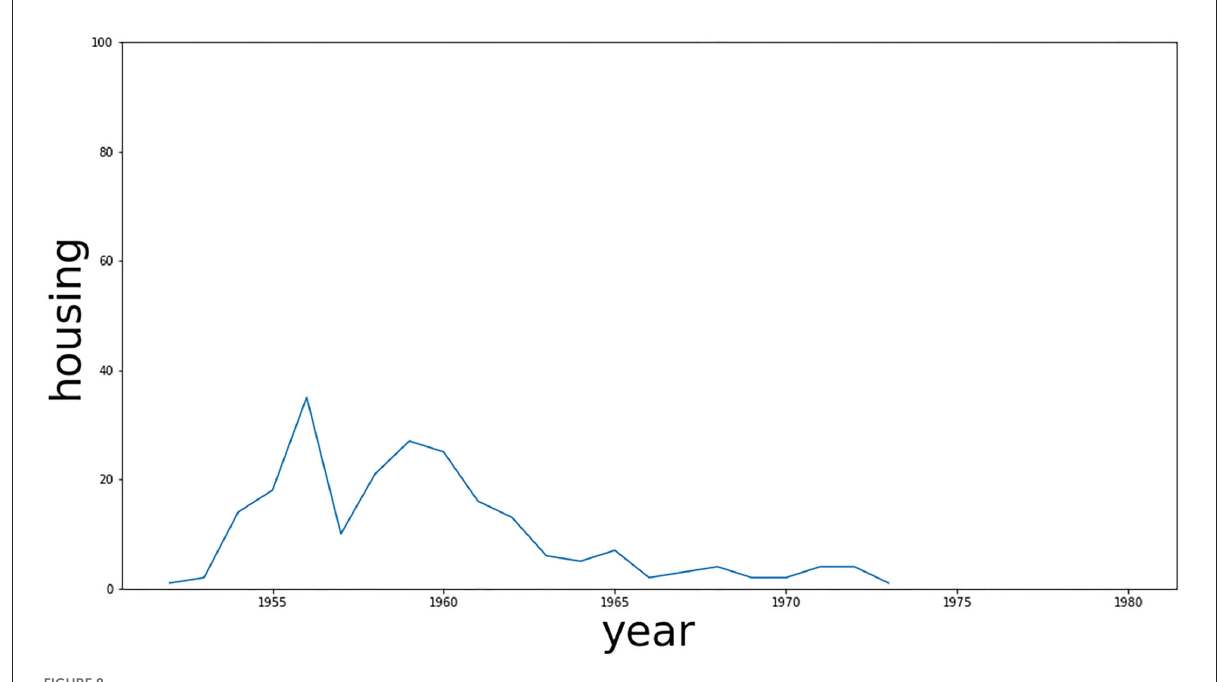
FIGURE8 Housing events per year—(source—emigrant registration